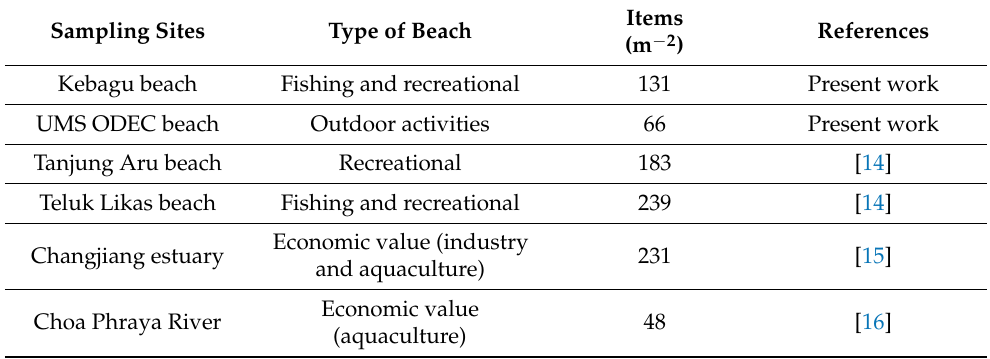
Table 1. Comparison with the average quantity of plastic debris (items m − 2 ) from other sampling sites. Sampling